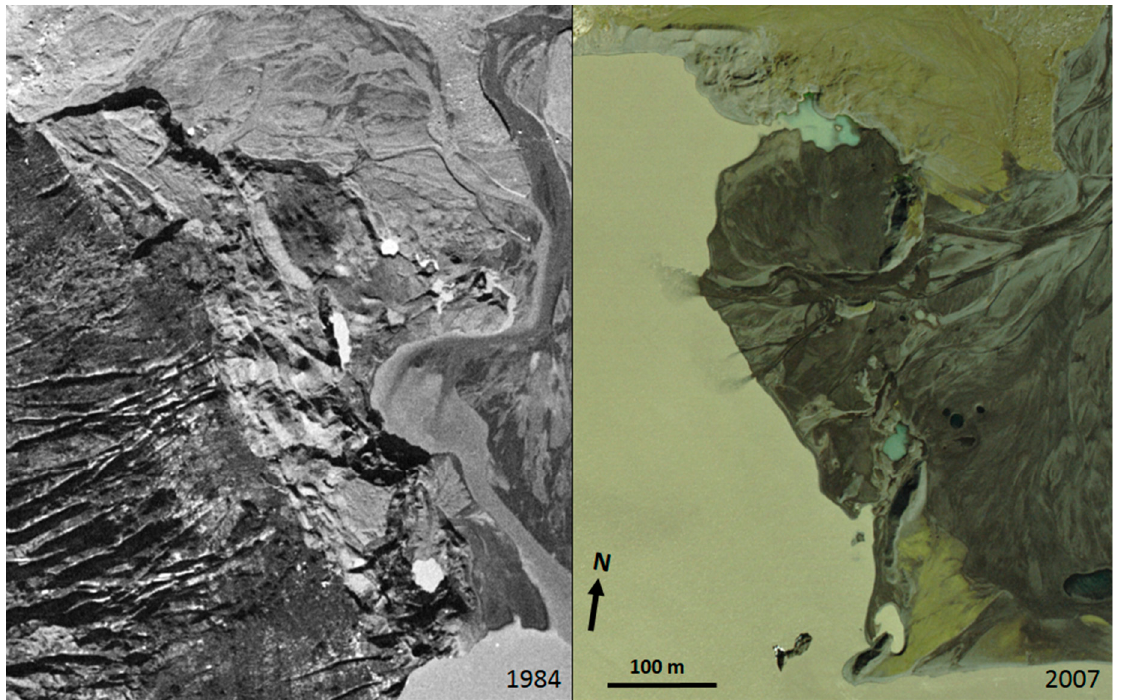
Figure 16. Aerial photograph extracts from 1984 (Landmælingar Islands) and 2007 (NERC ARSF) showing the development and collapse of push moraines in ice-cored glacifluvial deposits.